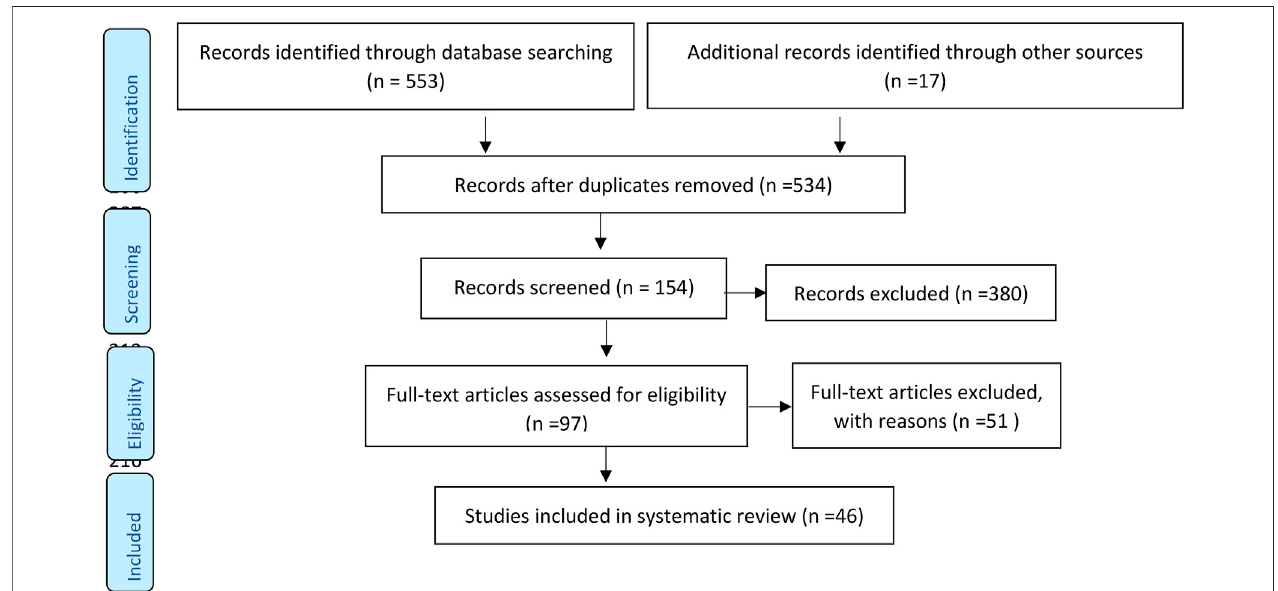
FIGURE 3 | PRISMA fl ow